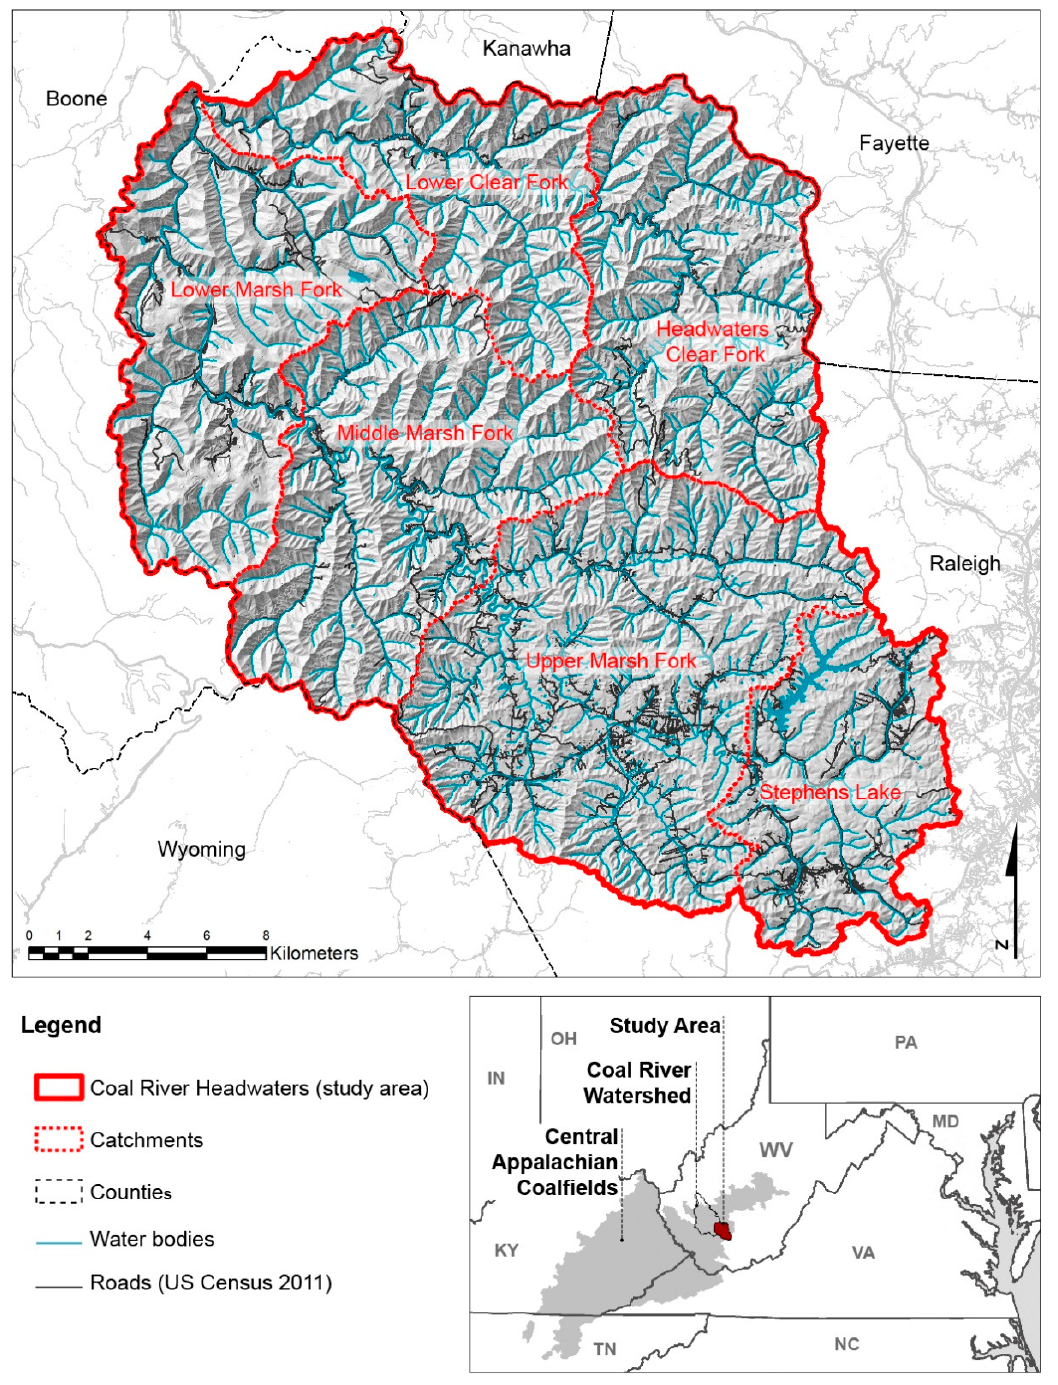
Figure 3. Map of the study area.